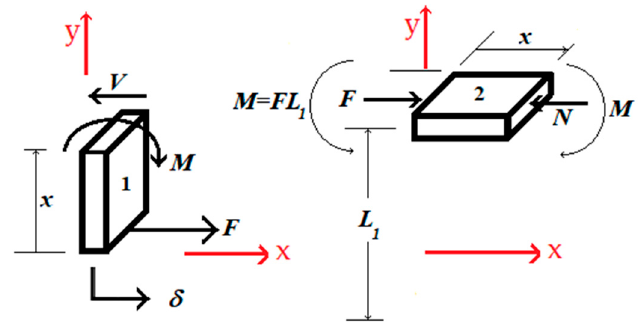
Figure 10. Internal shear forces and bending moments.